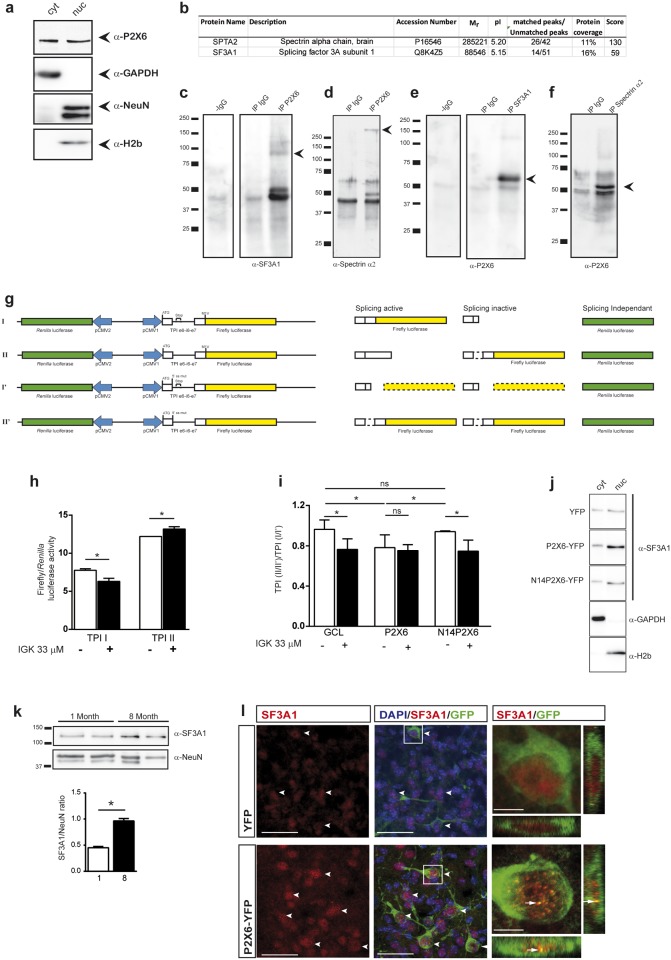
P2X6 subunit interacts with SF3A1 and Spectrin α2 in nuclear extracts from hippocampus of 8 month-old mice and alters splicing efficiency in vitro.(a) Western blot of subcellular fractions from 8 month-old mice hippocampus. P2X6 subunit was located in both the cytosolic (cyt) and the nuclear fraction (nuc), as identified by localization with either glyceraldehyde-3-phosphate dehydrogenase (GAPDH) or NeuN (neuronal nuclei marker)/histone 2b (H2b), respectively. (b) Nuclear extracts immunoprecipitated with anti-P2X6 antibody were resolved in a 2D electrophoresis gel and selected spots were isolated, processed and identified by MALDI/TOF (n = 3 mice). (c-f) Nuclear extracts immunoprecipitated with either IgG or anti-P2X6 antibodies were analysed by immunoblotting with antibodies against SF3A1 (c) and spectrin α-2(d). Nuclear extracts were also immunoprecipitated with spectrin α-2 (e) or SF3A1 (f) antibodies and immunoblotted with anti-P2X6 antibody. (g) Scheme shows four DNA constructions prepared for splicing activity quantitation and their respective protein translations. (h) Splicing inhibitor isoginkgetin (IGK) was used to validate the molecular tools employed to quantify the splicing efficiency. As expected TPI I firefly luciferase-dependent luminescence decreases and TPI II firefly luciferase-dependent luminescence increases when splicing is impaired (mean±s.e.m., n = 5 independent experiments, * P<0.05 unpaired Student’s t-test). (i) Overexpression of full-length P2X6 subunit reduces splicing activity in neuroblastoma cells compared to either control (GCL) or N14P2X6 transfected cells. The inhibition is similar to those produced by IGK (mean±s.e.m normalized values, n = 3 independent experiments, * P<0.05 unpaired Student’s t-test, ns P>0,05 unpaired Student’s t-test). (j) Western blot of subcellular fractions from neuroblastoma cells transfected with YFP, P2X6-YFP or N14P2X6-YFP, showing an increase of SF3A1 in the nuclear fraction only in P2X6-YFP transfected cells. (k) Western blot of hippocampal nuclear fractions from 8 month-old mice showing an increase of SF3A1 in the nucleus (n = 4 mice, *P<0.05 unpaired Student’s t-test). (l) Developing mice (E14.5) were in utero electroporated with YFP or P2X6-YFP and harvested at P0. Brain sections were labeled with antibodies against GFP and SF3A1, showing an increase of SF3A1 in the nucleus of transfected neurons. Arrows heads indicate transfected cells with high SF3A1 expression and full arrows show evident dotted pattern colocalization of SF3A1 and YFP. Scale bar 25 μm. Enlarged view scale 5 μm.